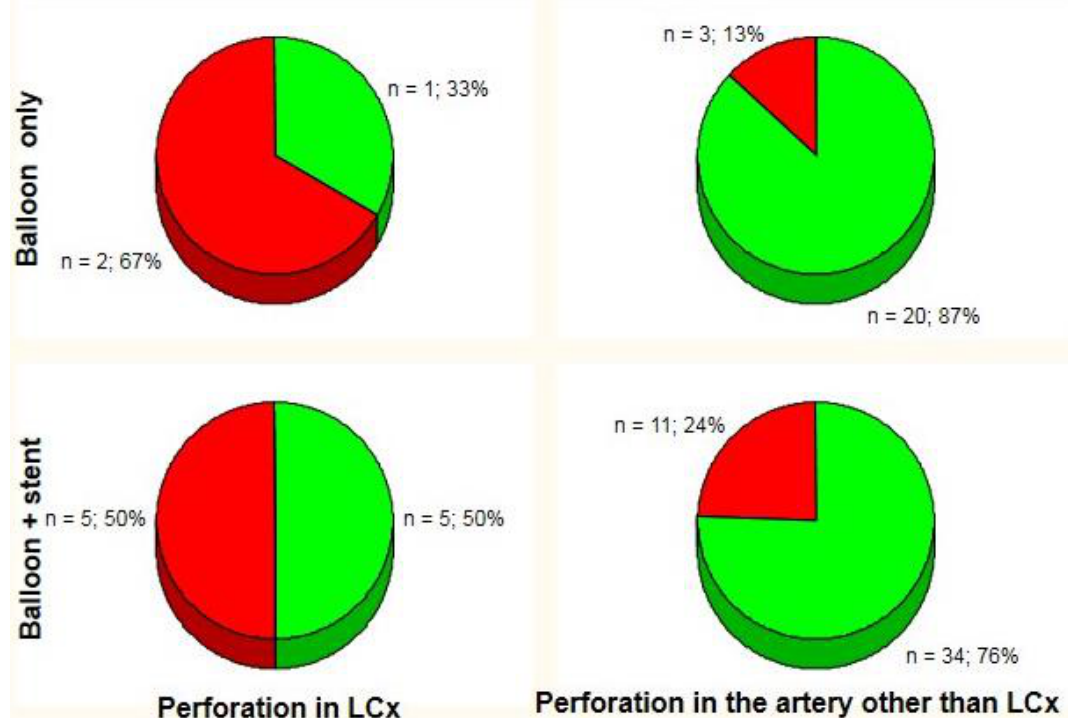
Figure 2. Incidence of acute cardiac tamponade (red area) by management strategy and perforation site. LCx: left circumflex coronary artery.